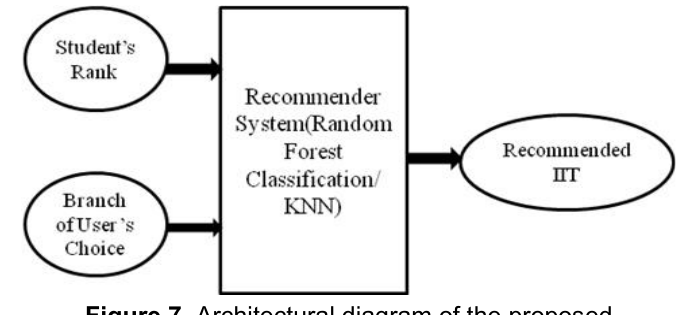
Figure 7. Architectural diagram of the proposed